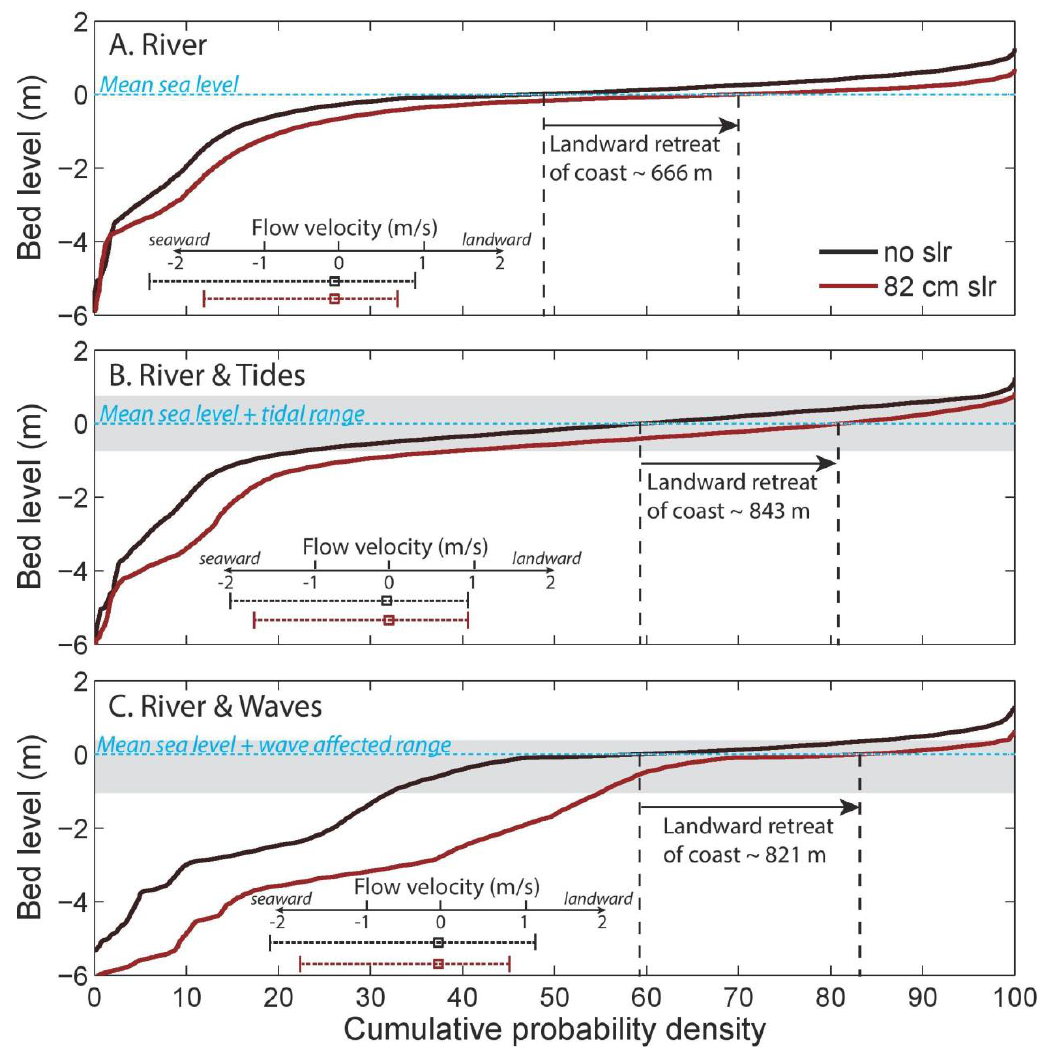
Figure 3. Integrated shoreline profiles relative to the mean sea level for deltas with SLRs of 0 cm (black) and 82 cm (red). ( A ) River-dominated delta coasts. ( B ) River- and tidally-influenced delta coasts. The simulated tidal range of 1.5 m is indicated in grey. ( C ) River- and wave-influenced delta coasts. The simulated wave range is indicated in grey with an upper range of 0.5 m, corresponding to the simulated significant wave height. The lower bound corresponds to the wave base, which is calculated as 0.5 times the wave length (in turn, calculated as wave velocity (0.5 m/s) times wave period (5 s)). The transition from subaqueous to subaerial delta is indicated by the horizontal blue dash line (see also Table 1 for descriptive statistics). The difference between the vertical black dash lines corresponds to the average shoreline retreat between 0 cm and 82 cm of SLR. Flow velocity statistics show a decreased velocity range for deltas with 82 cm SLR compared to no SLR.